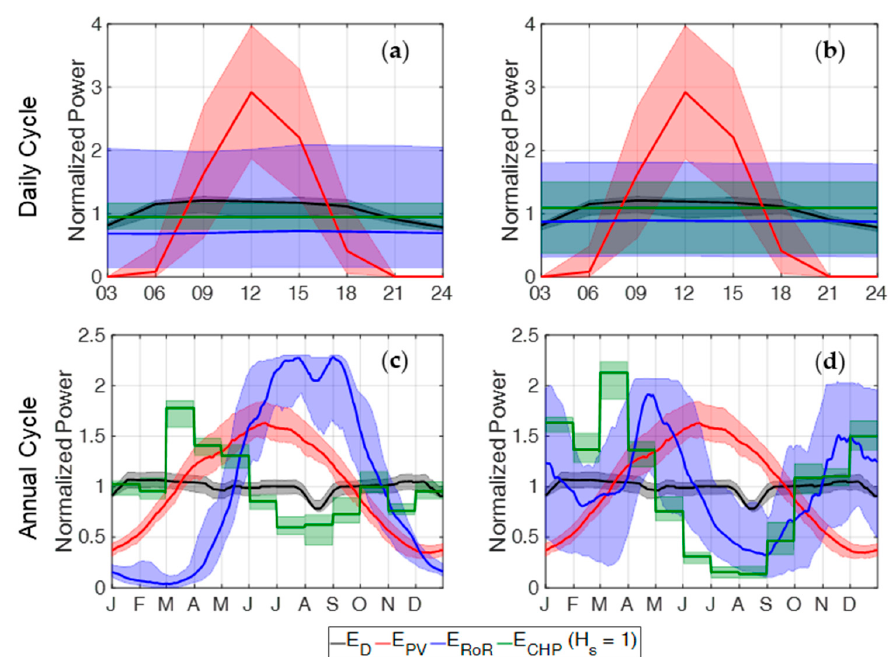
Figure 3. Daily ( a , b ) and annual ( c , d ) average cycles of solar PV (red), RoR hydropower (blue) and CHP (green) electricity generation, as well as demand (black), for the districts of Saldura at Mazia ( a , c ) and Posina at Stancari ( b , d ). Average cycles are obtained for the period 2000–2008. The shaded areas illustrate the sub-daily (top) and inter-annual (bottom) variability of the considered signal by showing the deviation between the 25th and 75th percentiles of their conditional distribution. Annual cycles are smoothed over a 10-day period. All cycles have been normalized (average = 1) to highlight the various patterns of demand and electricity generation at both temporal scales.